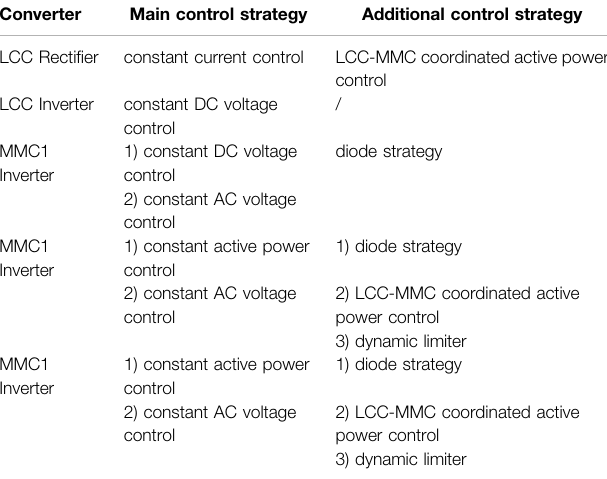
TABLE 3 | The control strategies of each